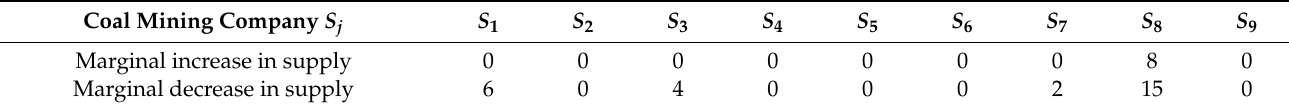
Table 6. Marginal supply change of stable